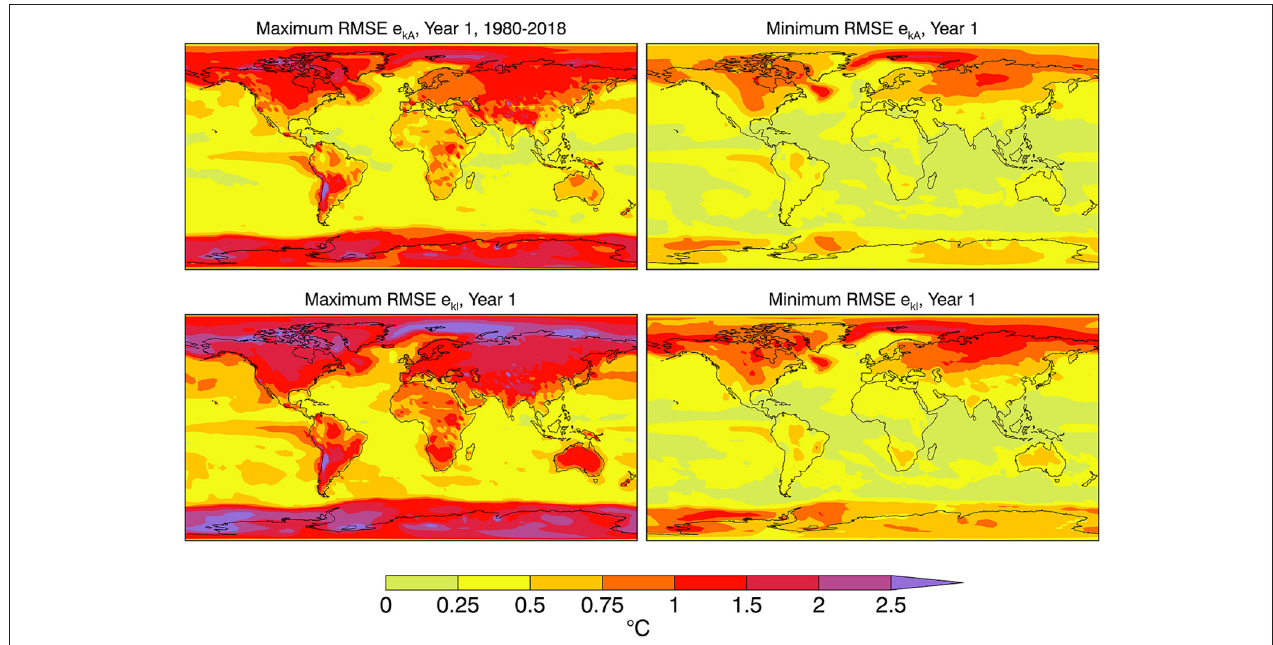
FIGURE 12 | The (left) maximum and (right) minimum root mean square error (top) e kA of different analyses X k compared to the ensemble mean forecast Y A , and (bottom) e kl of individual analyses X k and forecast members Y l for Year 1.